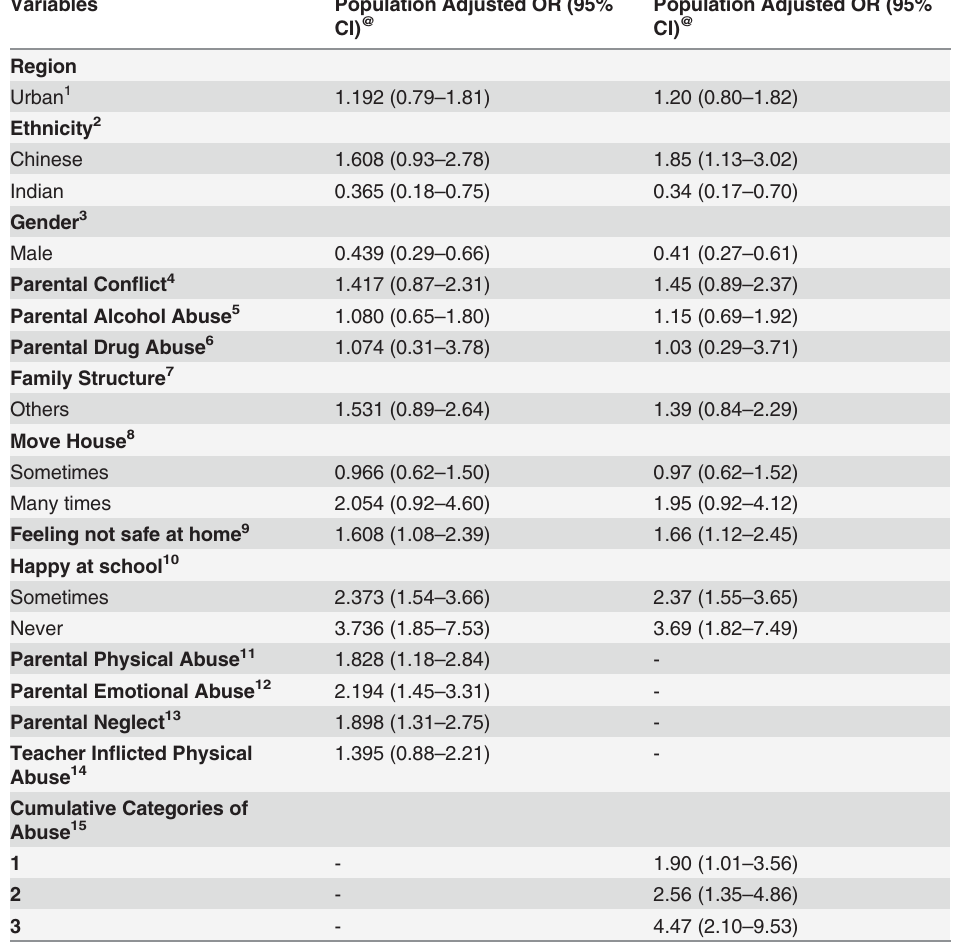
Table 3. Multivariate associations between a CES-DC score greater than 31 and socio-demographic factors, and (A) maltreatment categories as well as (B) cumulative maltreatment.